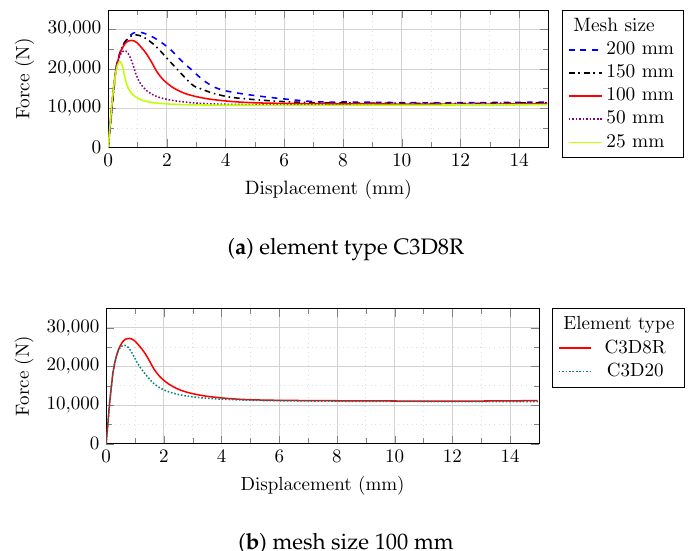
Figure 12. Mesh sensitivity analysis of the ECC sheet: ( a ) different mesh sizes; ( b ) different ele- ment